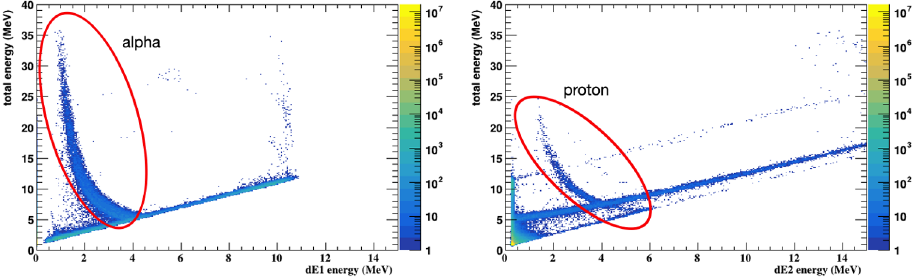
Figure 2. The particle identification using ∆ E-E method. This data are from one of the lower angle telescope (Tel2). The left panel shows the total energy vs. the energy detected at dE1 and the right panel shows the total energy vs. the energy detected at dE2. The left and right loci indicate the α and p,